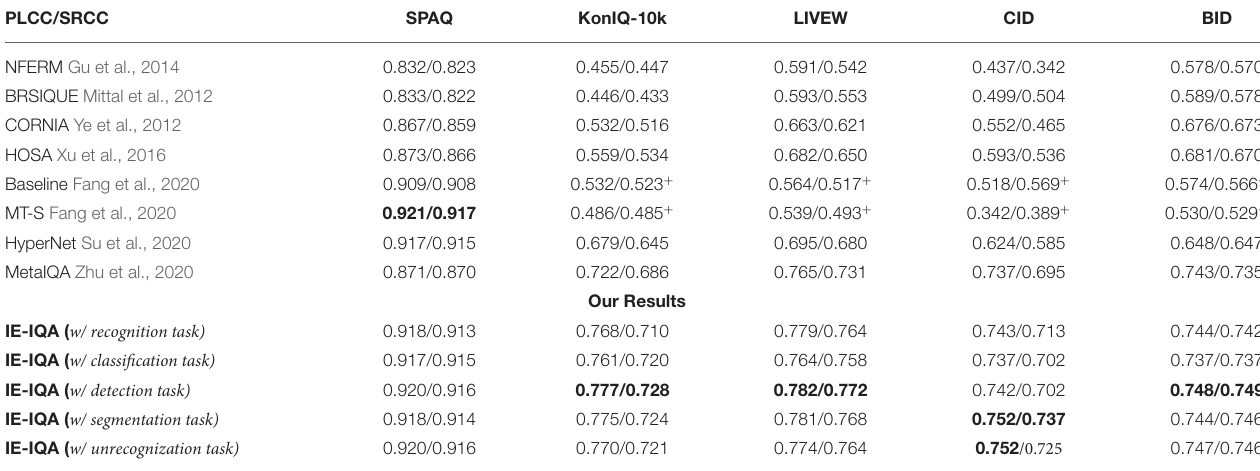
TABLE 2 | Pearson’s linear correlation coefficient (PLCC)/Spearman’s rank order correlation coefficient (SRCC) results of cross-dataset test.